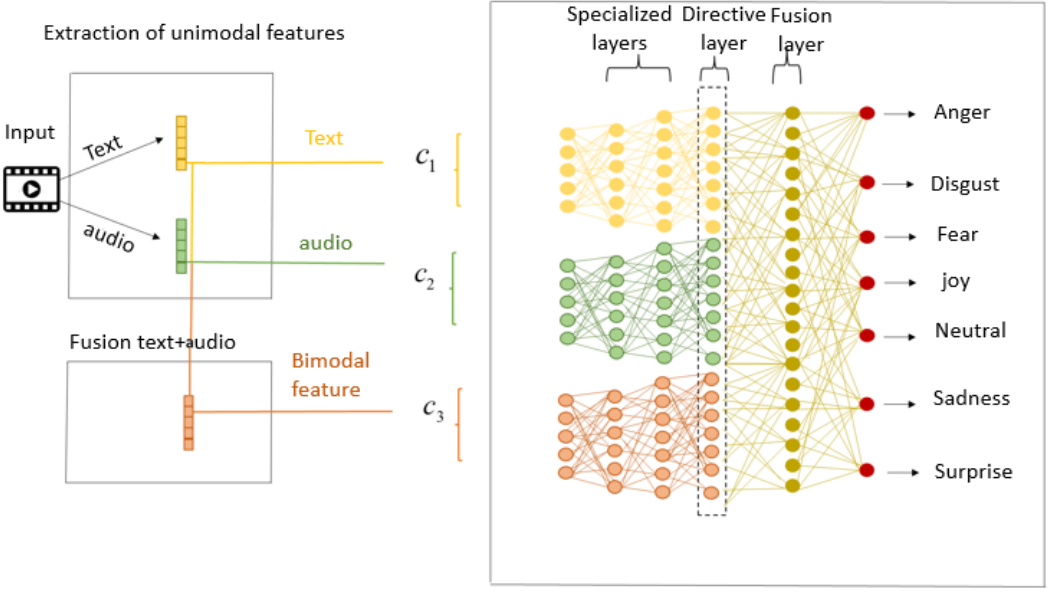
Figure 4. General structure of our proposed approach.